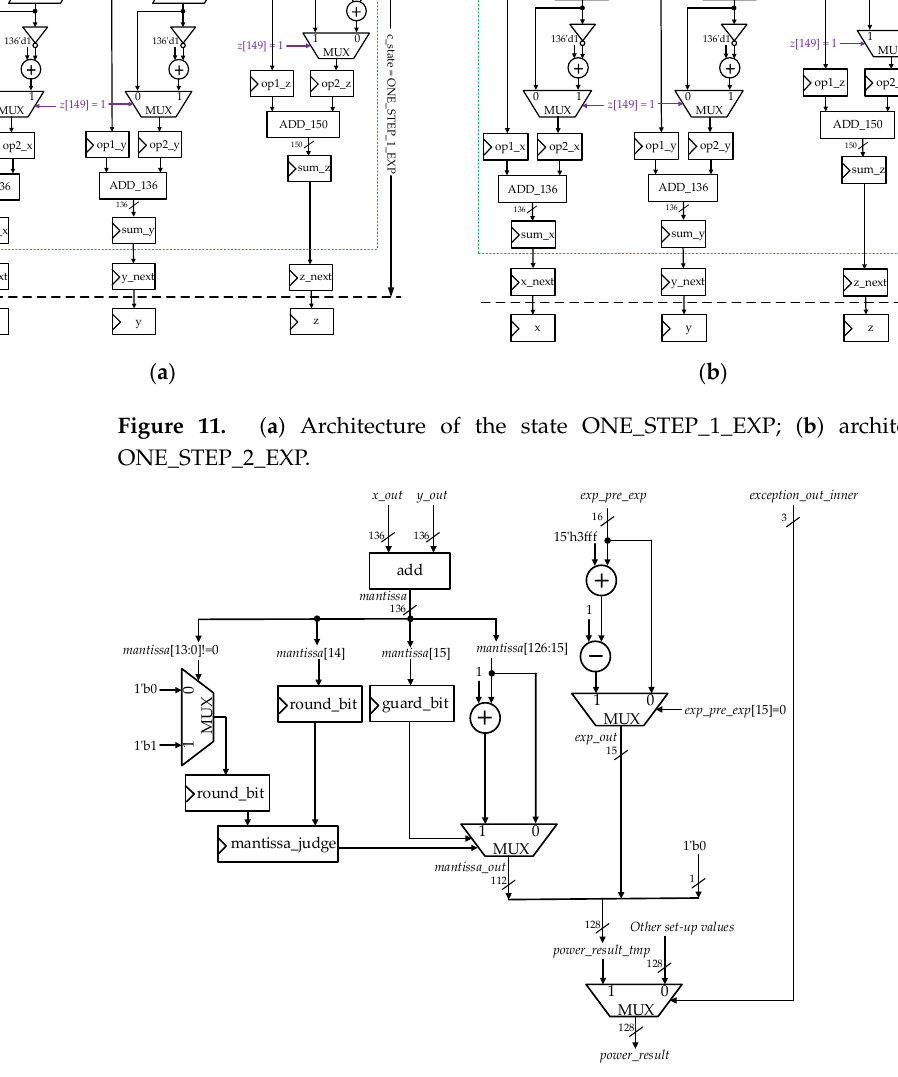
Figure 10. ( a ) Architecture of the state ONE_STEP_1_LN; ( b ) architecture of the state ONE_STEP_2_LN. Figure 11a,b demonstrate architectures of State ONE_STEP_1_EXP and state ONE_STEP_2_EXP, respectively. The two blue boxes in Figure 11a,b jointly make up the repetitive iterative x n + 4 , y n + 4 and z n + 4 data path for exponential functions.